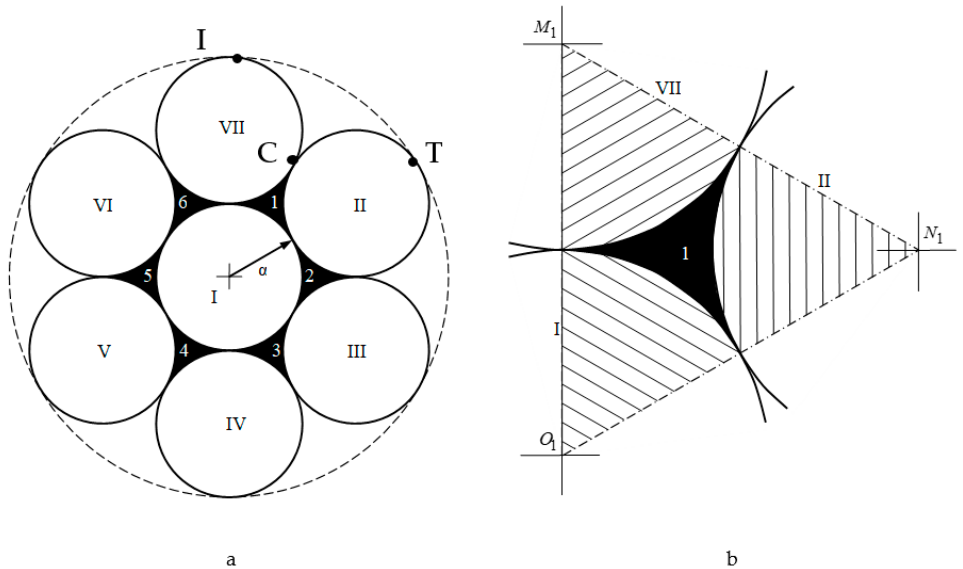
Figure 13. ( a ) Jullien fractal after the first iteration, ( b ) a schematic representation to calculate the area of one curved equilateral triangular cell.